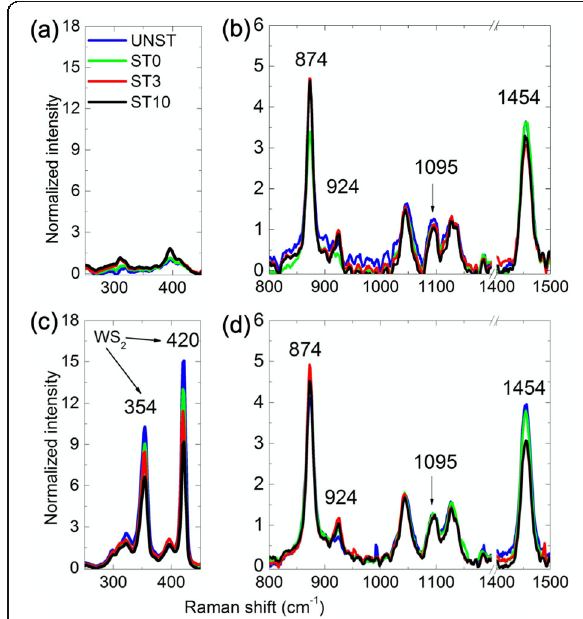
Fig. 6 Raman spectra of PLA (a, b) and PLA-WS 2 0.6% (c, d) measured on UNST, ST0, ST3 and ST10 samples. The spectra have been normalized with respect to the intensity of the PLA band at 1095 cm −